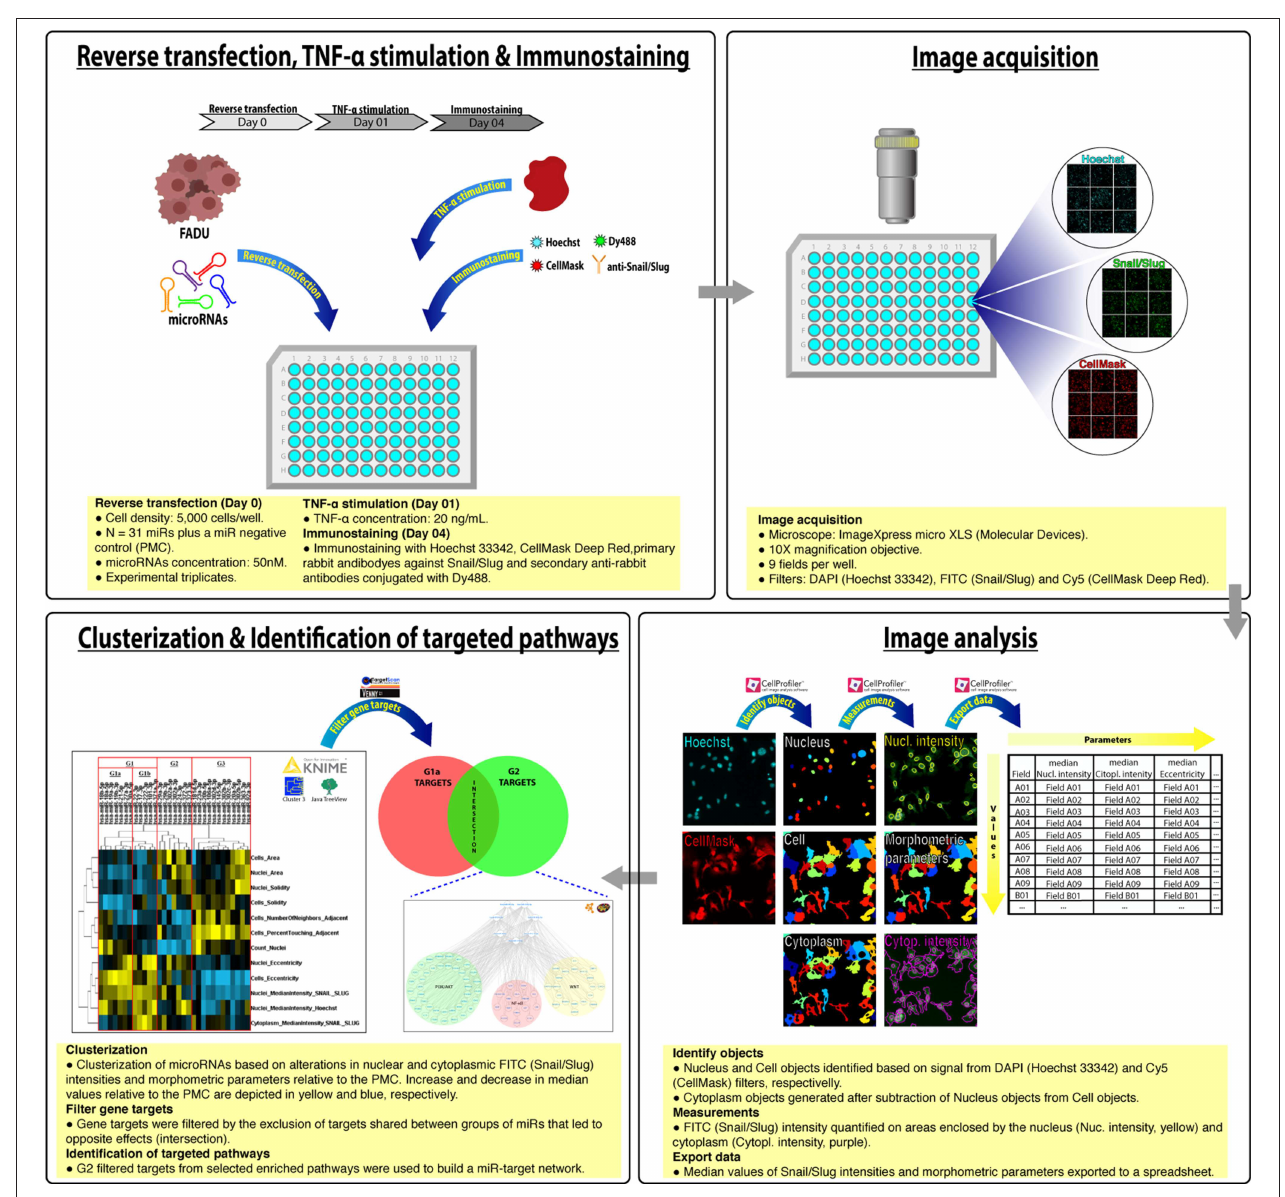
FIGURE 1 | Study design. Reverse transfection, TNF- α stimulation and Immunostaining: Cells from the FADU cell line were transfected (day 0) with microRNAs ( N = 31), followed by stimulation with TNF- α (20ng/mL, Day 01) and immunostaining with primary rabbit antibodies against Snail/Slug, secondary anti-rabbit antibodies conjugated with Dy488, nuclear (Hoechst) and cytoplasmic (CellMask) fluorescent dyes (Day 04). Image acquisition: Images (9 fields per well) were acquired using a 10X objective and excitation/emission filters DAPI (Hoechst), FITC (Snail/Slug), and Cy5 (CellMask), using an ImageXpress Micro XLS HCS system (Molecular Devices). Image analysis: Nuclei and corresponding cytoplasm objects were identified and segmented based on images from DAPI (Hoechst) and Cy5 (CellMask) channels, respectively. FITC (Snail/Slug) intensity on nuclei and cytoplasm, as well as morphometric parameters were then quantified. Median values per field were exported into a spreadsheet. Clusterization and Identification of targeted pathways: Based on alterations in median values per well relative to the PMC, microRNAs were subjected to an unsupervised hierarchical clustering. After the exclusion of genes commonly targeted by miRs from G1a (pro-survival/EMT) and G2 (anti-survival/EMT), genes from signaling pathways targeted by G2 miRs were used to generate a microRNA regulatory